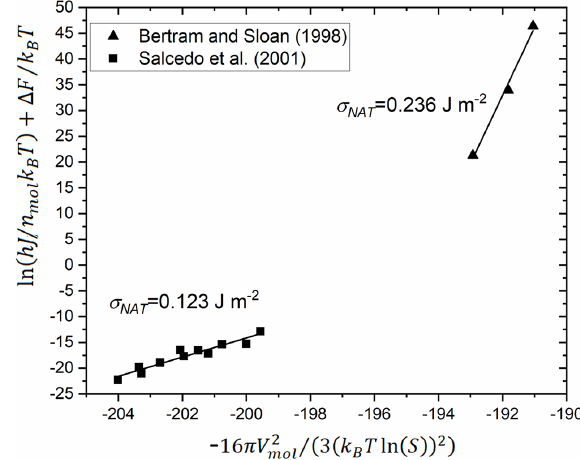
Figure 8. Reanalysis of measured homogeneous nucleation rates from Salcedo et al. (2001) (see their Fig. 7) and Bertram and Sloan (1998). Axes represent the linearised form of Eq. (4) sub- stituted into the equivalent of Eq. (1) for homogeneous nucleation (Murray et al., 2012). Linear regression fits and derived surface en- ergies are